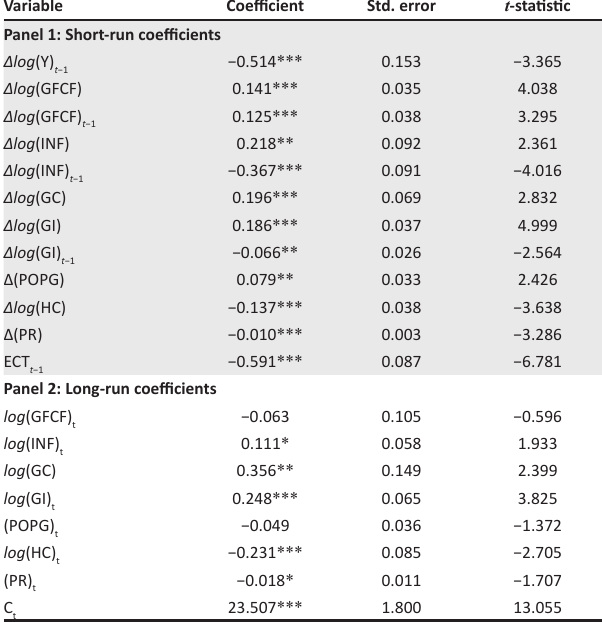
TABLE 6: Long-run and short-run results.